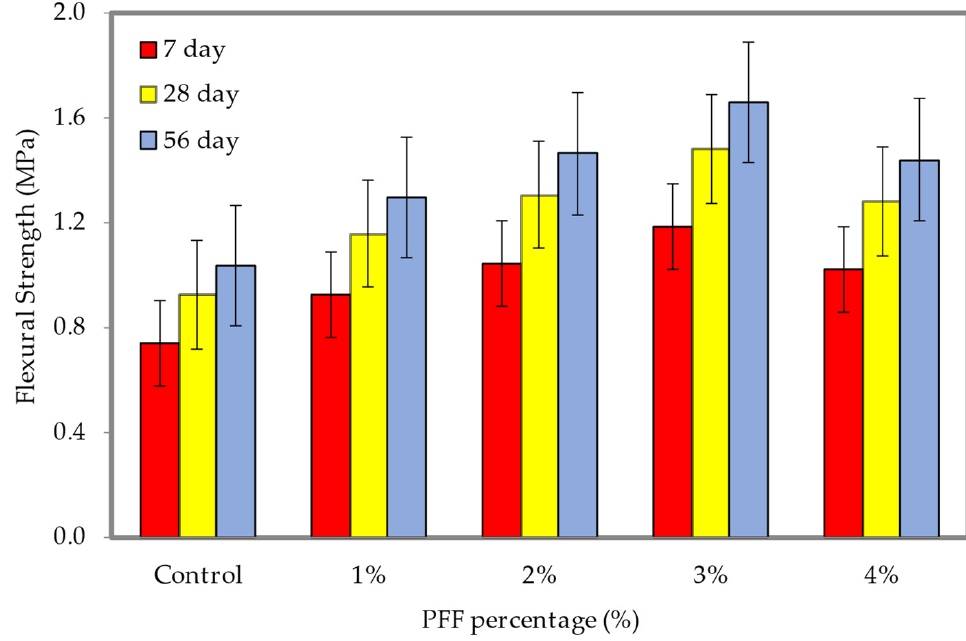
Figure 17. Flexural strength of foamed concrete of 1200 kg/m 3 density with varying PFF percentages.